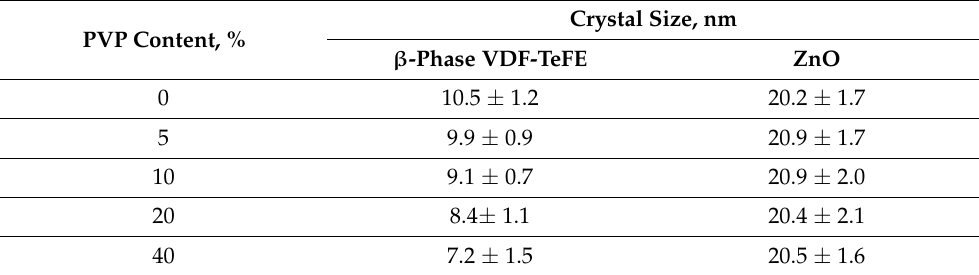
Table 3. Crystallite size in VDF-TeFE/PVP/ZnO membranes with various PVP contents.